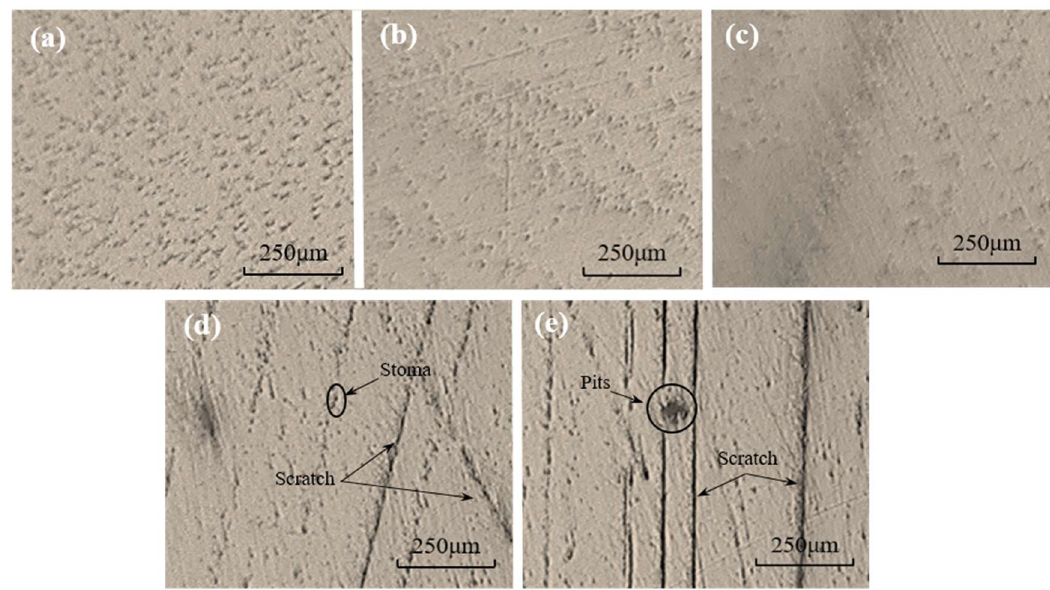
Fig. 7. Microscopic appearance under different polishing forces: (a) 5 N, (b) 10 N, (c) 15 N, (d) 20 N, (e) 25 N.